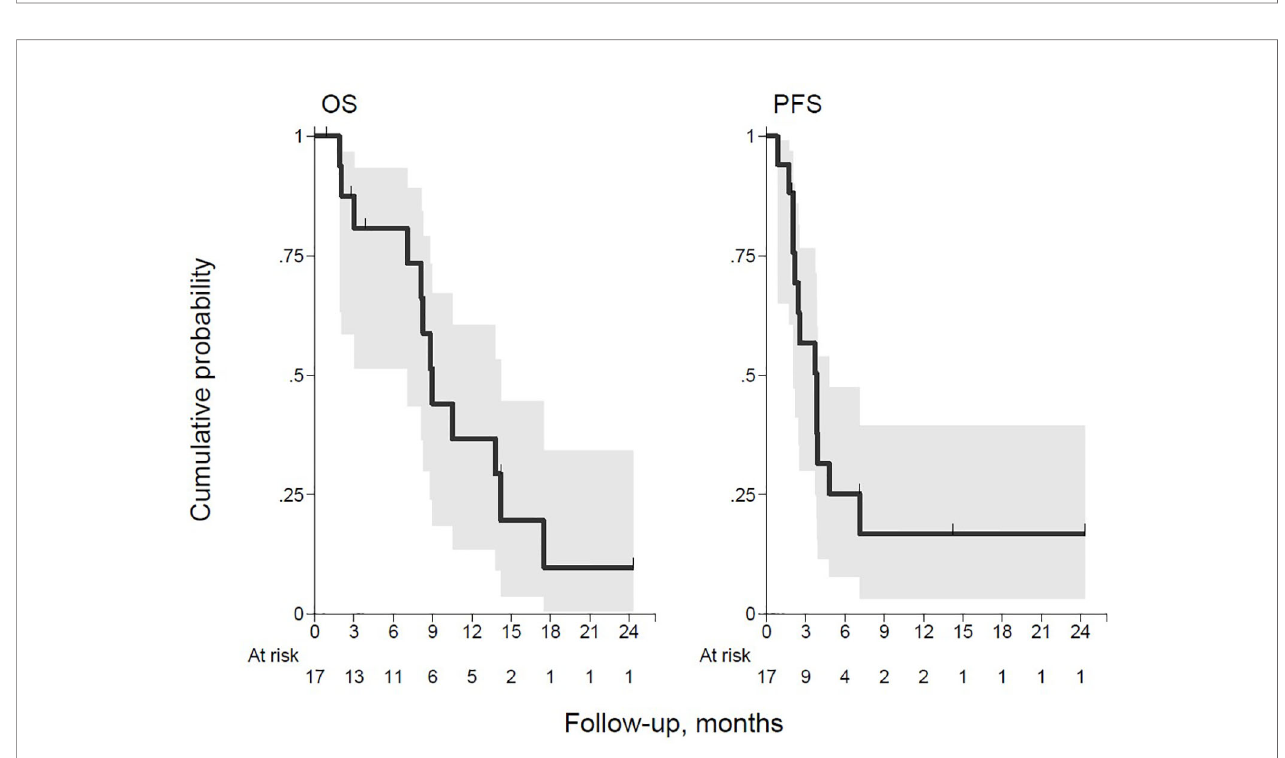
FIGURE 2 | Overall survival (OS) and progression-free survival